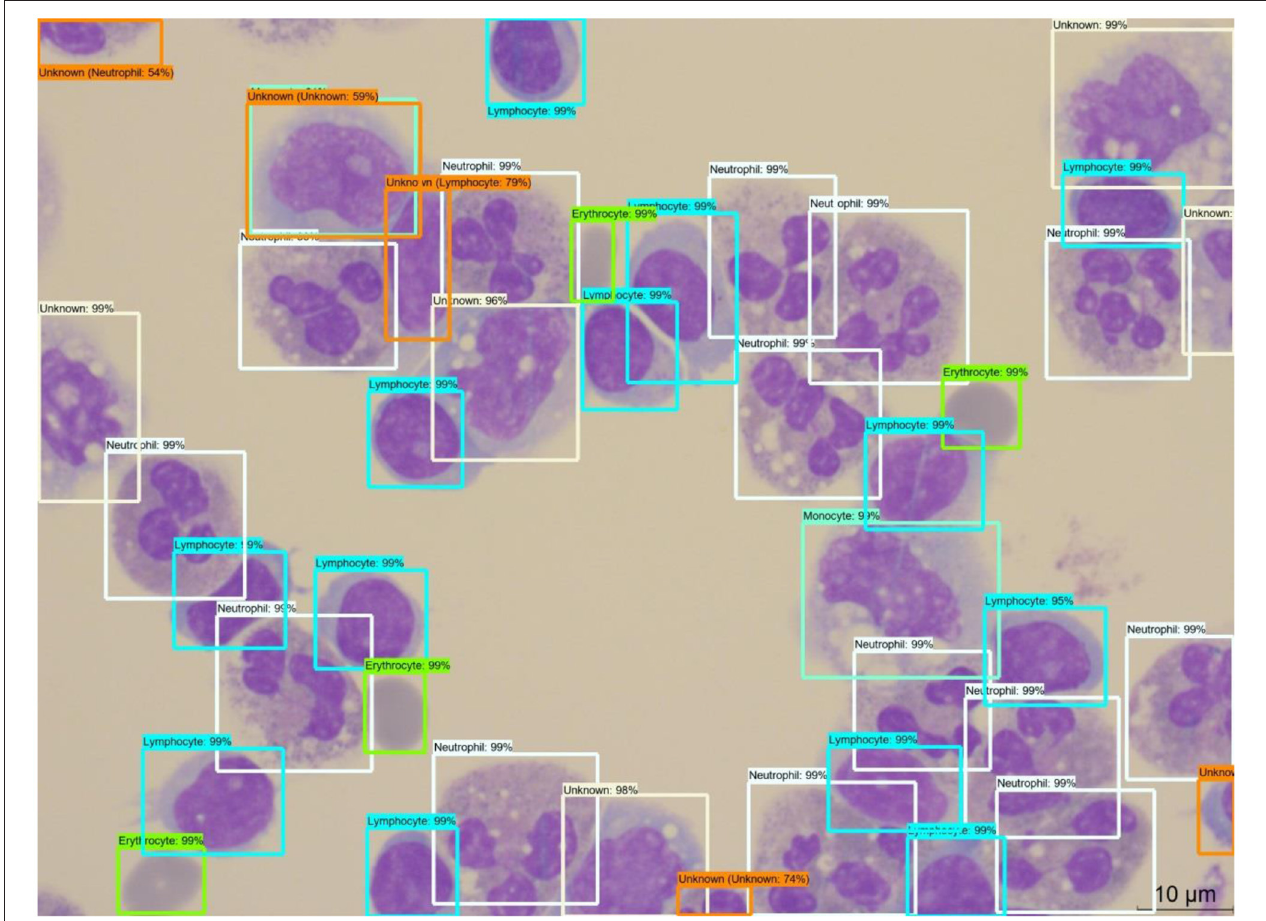
FIGURE 4 | An example output of the DNN model with boxed labels along with the model’s percentage prediction. One can see the predicted outputs of neutrophil, monocyte, lymphocyte, and erythrocyte with their respective colors along with the DNN model’s percentage prediction. In addition, some cells are labeled with the “unknown” label tag (tan and orange boxes) when the prediction percentage is below 80% or when the shape of the cell indicates a possibility of a rare cell type (i.e., basophil, eosinophil, mitotic, etc.). DNN, deep neural network.